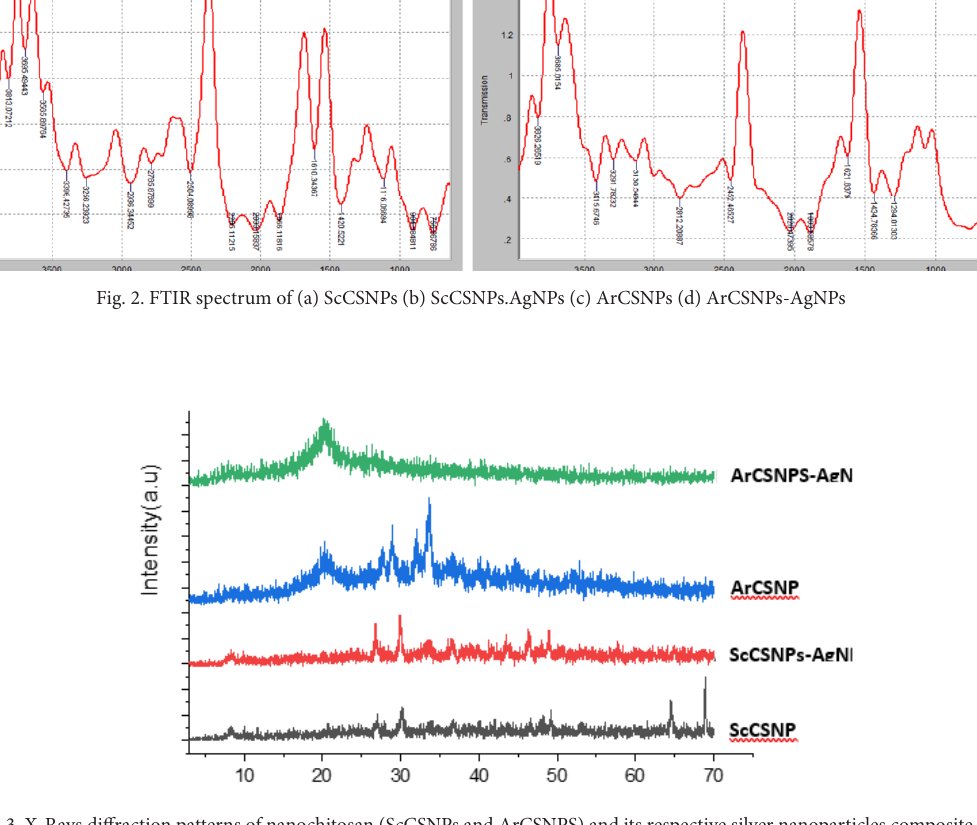
Fig. 3. X-Rays diffraction patterns of nanochitosan (ScCSNPs and ArCSNPS) and its respective silver nanoparticles composite (ScCSNPs-AgNPs and ArCSNPS-AgNPs)